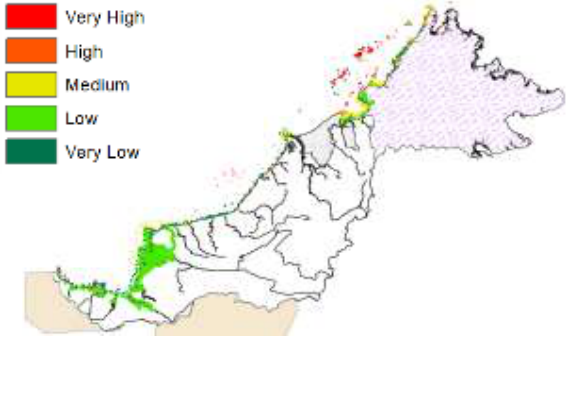
Figure 7: ESR map based on aggregation of expert’s prioritization of vulnerable marine